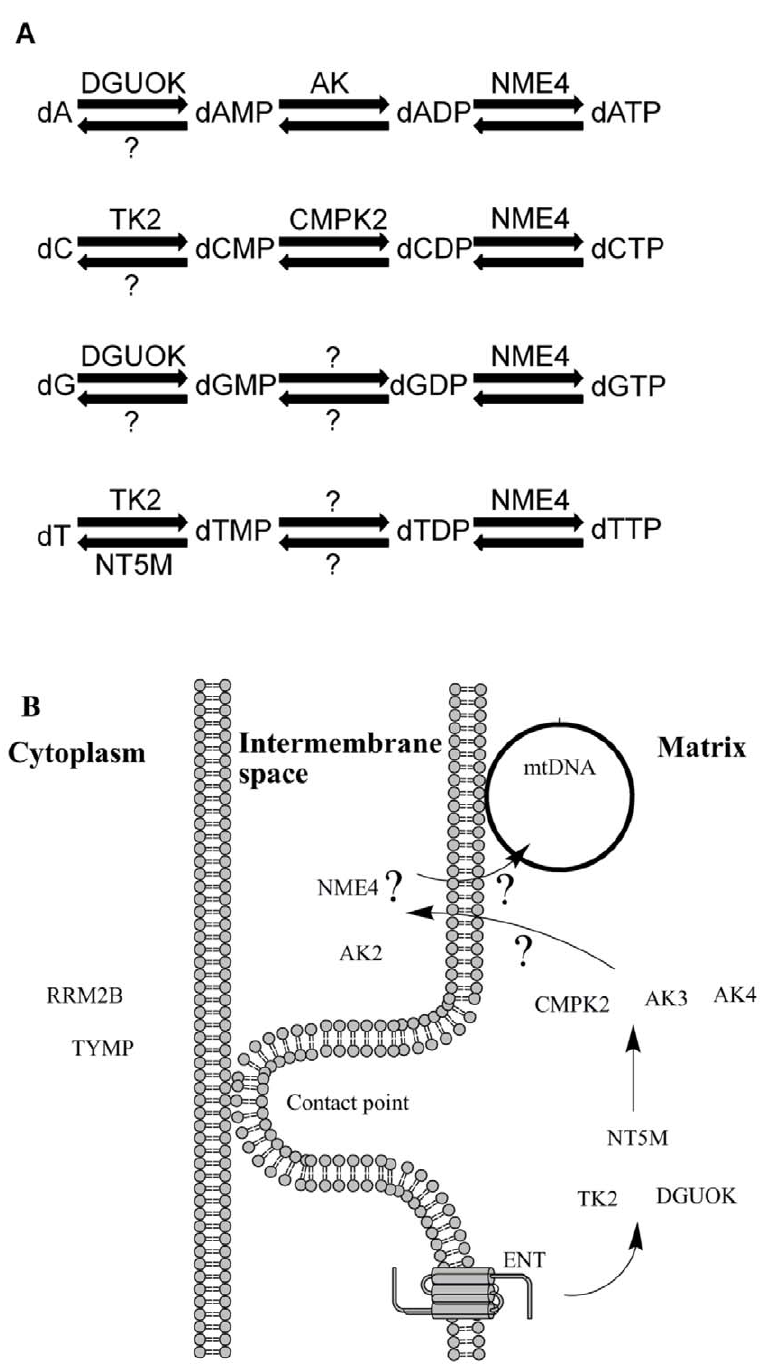
Figure 1. Mitochondrial deoxyribonucleoside salvage metabolism. ( A ) Biochemical pathway representation of the mitochondrial deoxyribonucleoside salvage metabolism. Deoxyribonucleosides undergo a series of reversible phosphorylations to become deoxyribonucleoside triphosphates (substrates for mtDNA replication). Enzymes that are yet to be identified are represented by question marks. ( B ) Subcellular localizations of some enzymes important for the production of intra-mitochondrial dNTPs. Arrows denote the flow of substrates between the enzymes. The question marks denote substrate flows that appear to be required by the enzyme localization data, but which seem unreasonable.